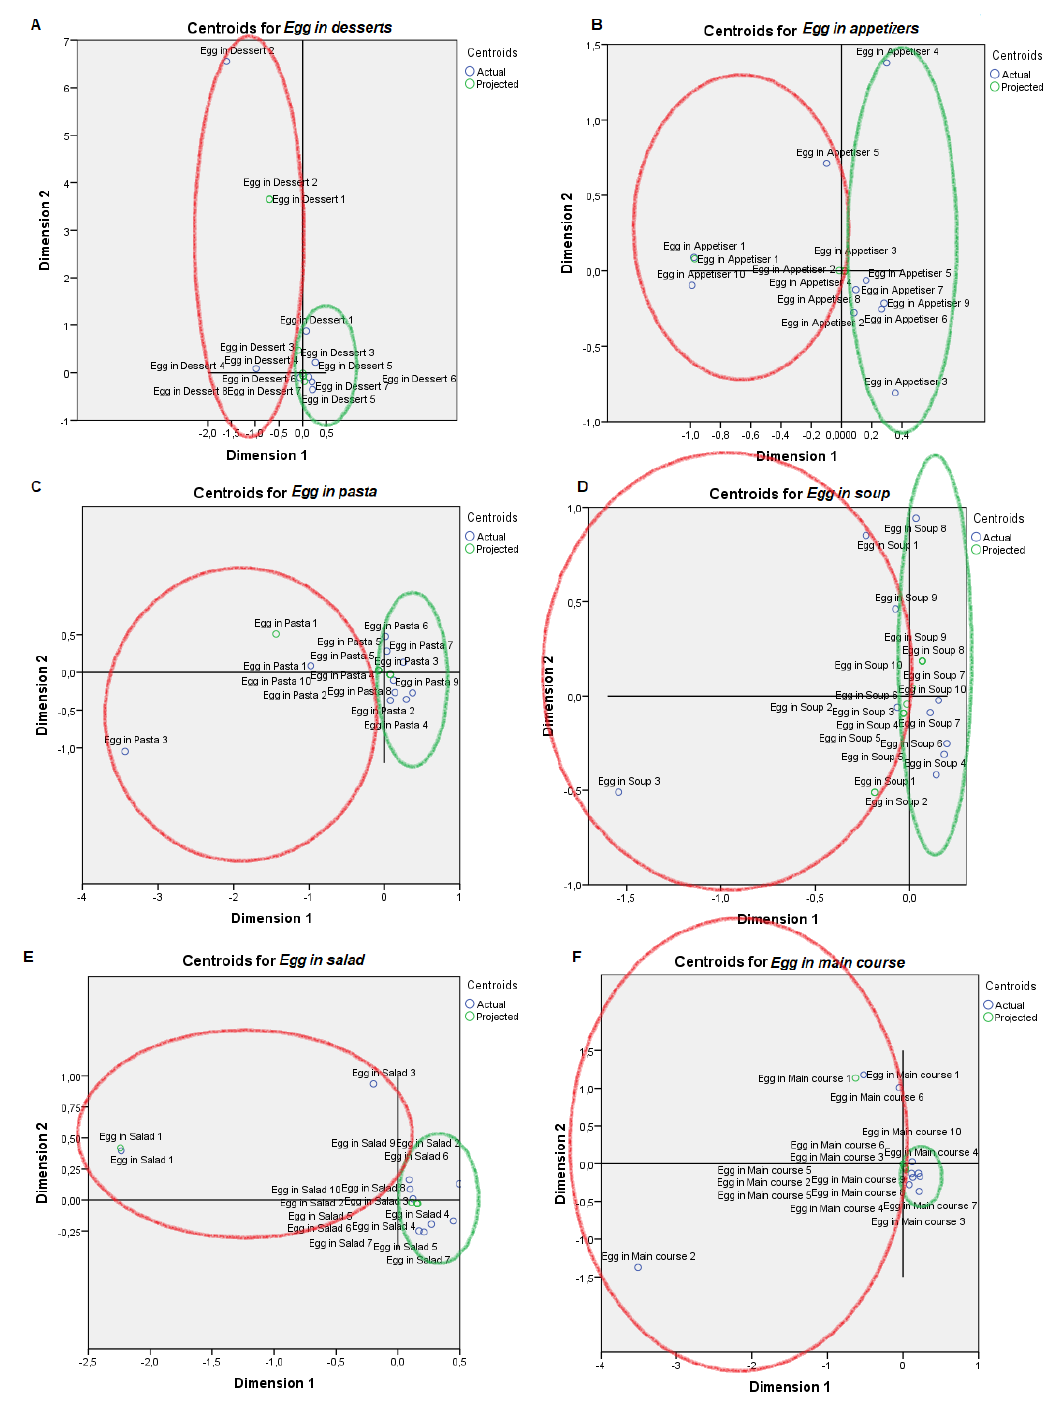
Figure 5. Object scores plot visualization of Professional Customer Profiles with regards cuisine applicability, egg consumption non-affine profile or PPA (red), and affine profile or PPB (green). Cuisine applicability was scored through: ( A ) Egg applicability in desserts, ( B ) in appetizers, ( C ) in pasta, ( D ) in soup, ( E ) in salad and ( F ) in main course.